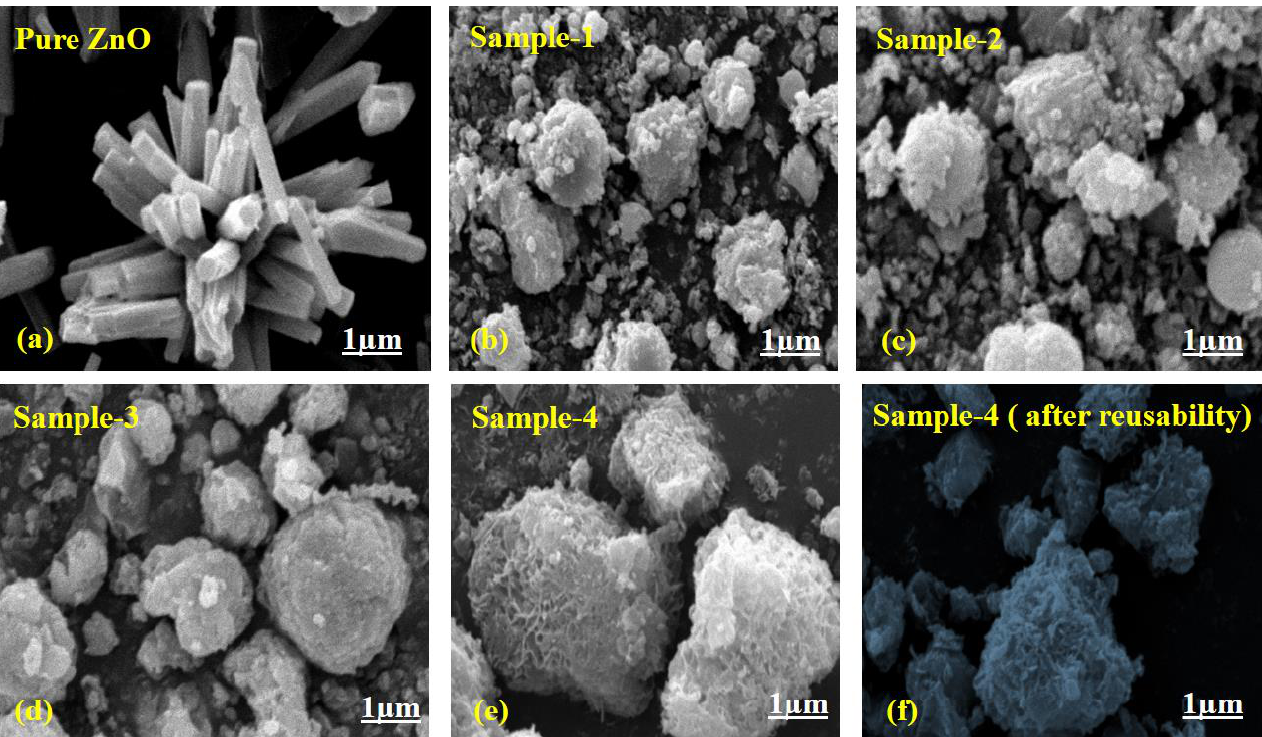
Figure 2. SEM images of ( a ) pure ZnO, ( b – e ) green synthesized ZnO samples treated with different amounts of leafy extract of S. oleracea (10 mL, 20 mL, 30 mL, and 40 mL), and ( f ) SEM image after reusability test.